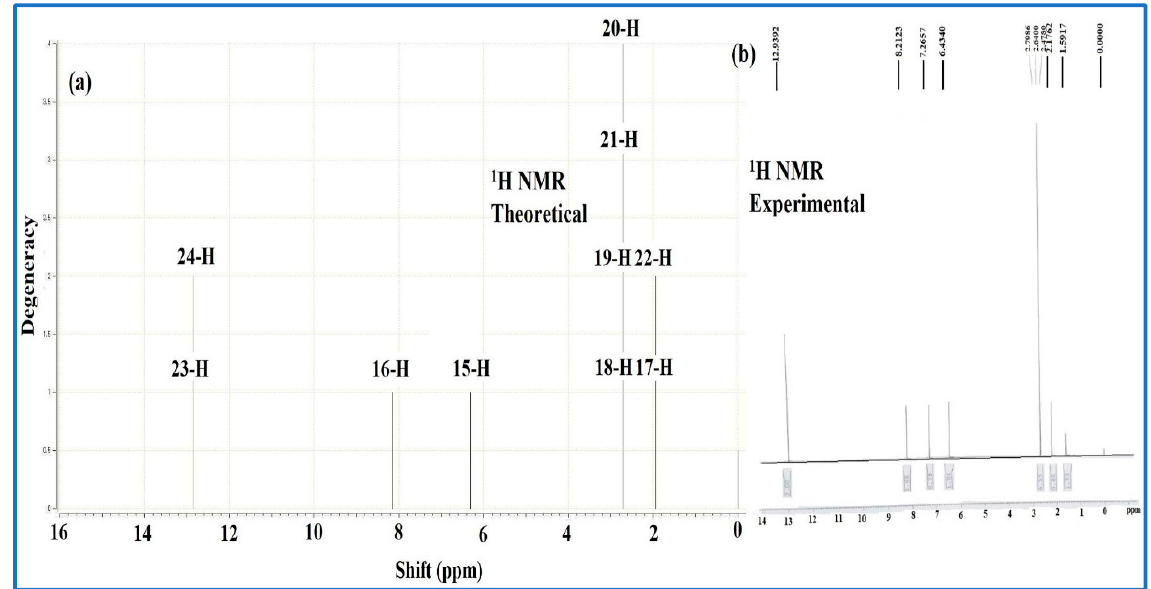
Figure 9. Calculated ( a ) and experimental ( b ) 1 H-NMR spectra of the isolated compound 1